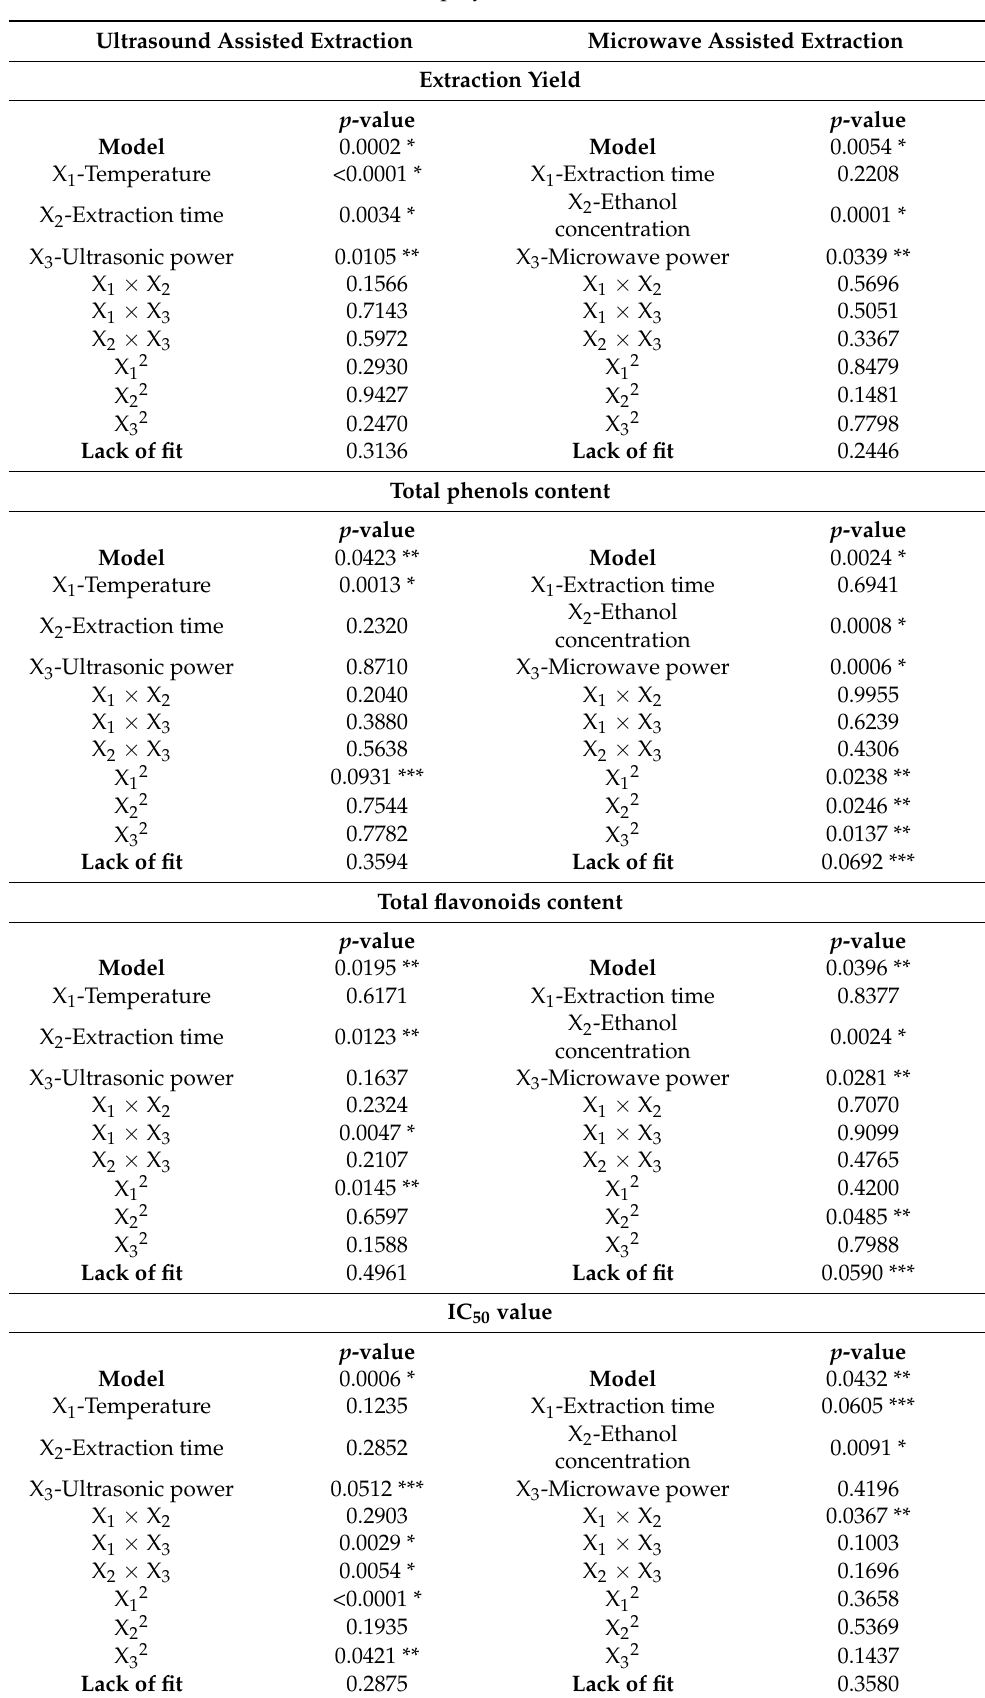
Table 3. ANOVA of the fitted second-order polynomial